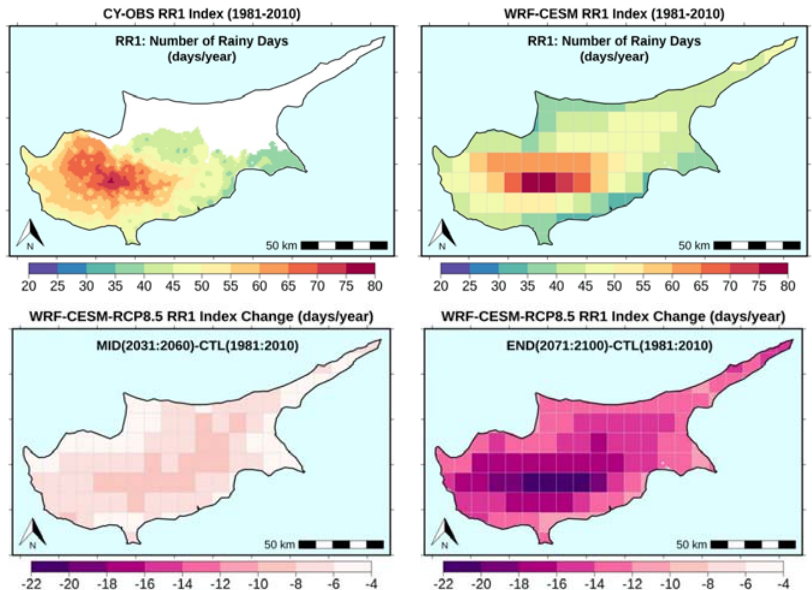
Figure 8. Observed ( top left ) and simulated ( top right ) number of rainy days per year (RR1) for the period 1981 to 2010 and projected changes for the middle ( bottom left ) and end of the 21st century ( bottom right ).